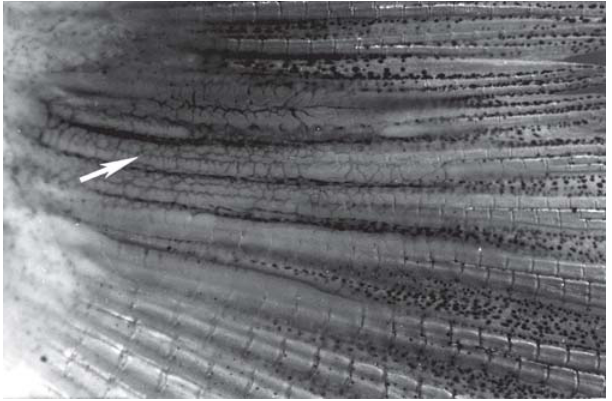
Fig. 14. Glandulocauda melanopleura , adult male, USNM 236415, 42.3 mm SL: detail of caudal organ showing beaded glandular tissue indicated by arrow. Lateral view, left side. Modified from Weitzman et al .